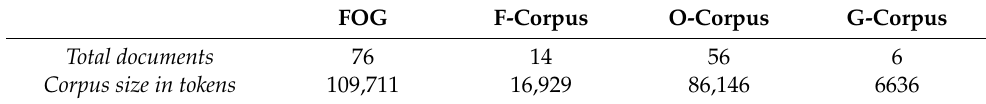
Table 1. Summary of features for the fatwa , guidance documents and other documents (FOG)